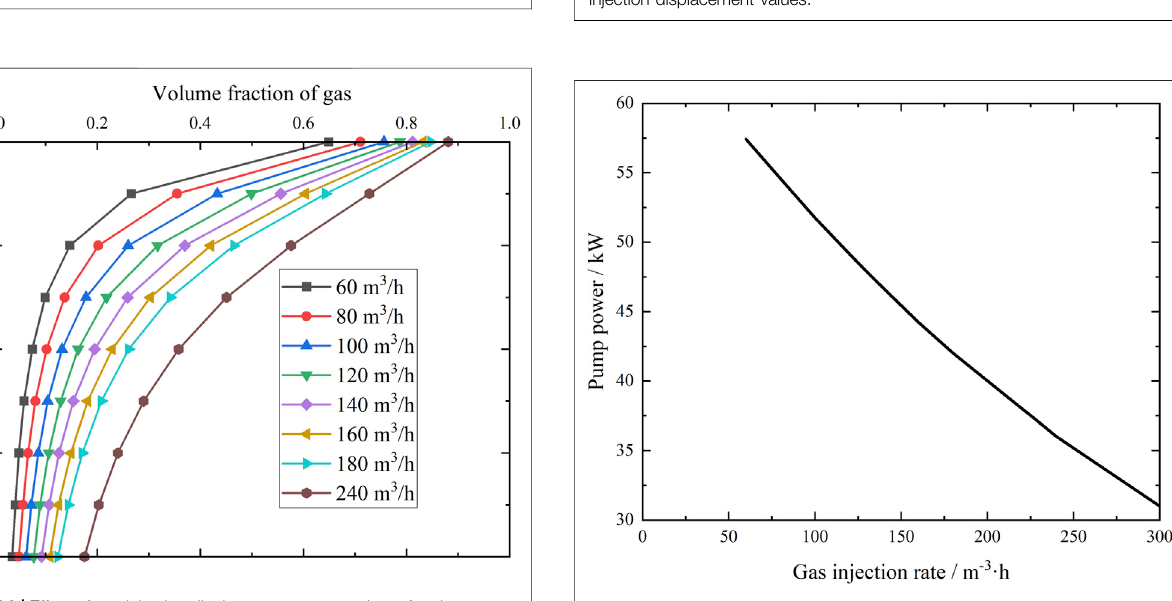
FIGURE 10 | Gas velocity distribution in the wellbore with different gas injection displacement values.